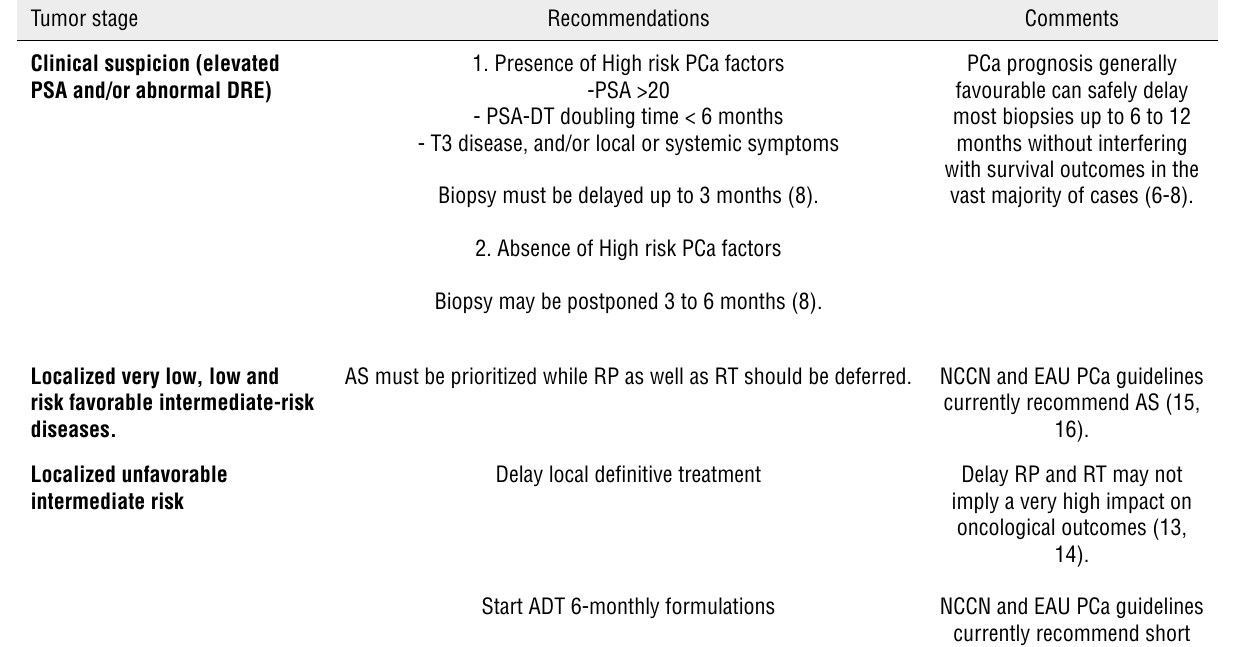
Table 1 - Management of clinical suspicion of PCa and localized PCa during the COVID-19